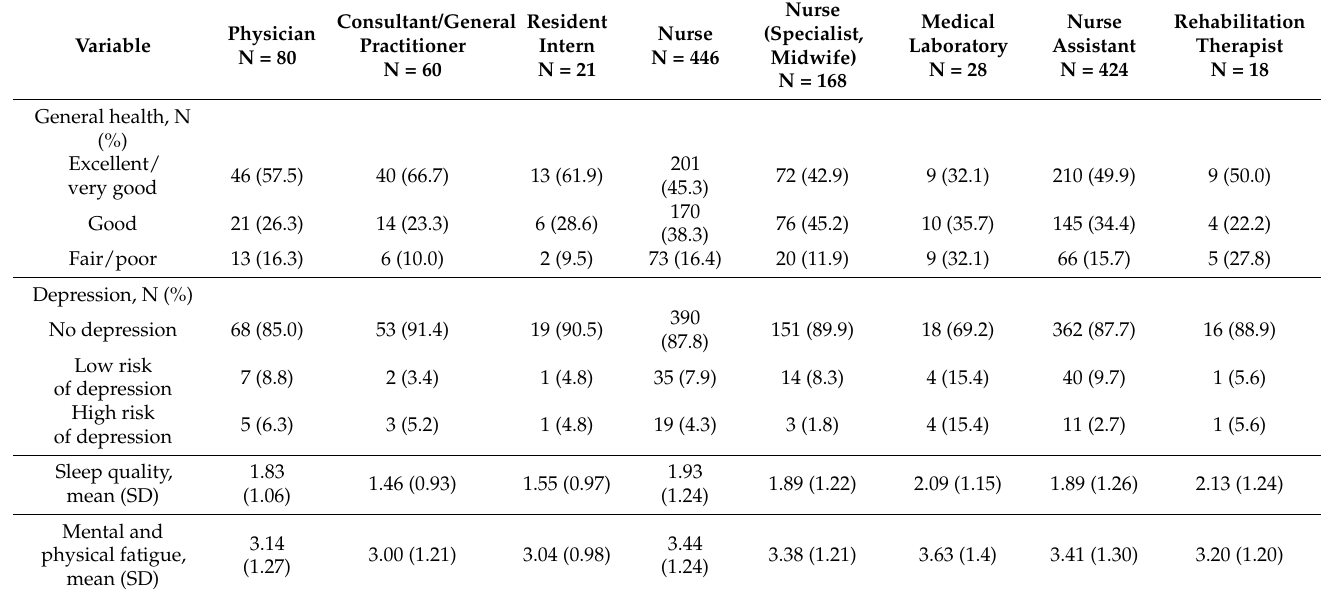
Table 4. Descriptive data for employee health in different occupational groups of health-care workers involved in COVID-19 care (N = 1352).